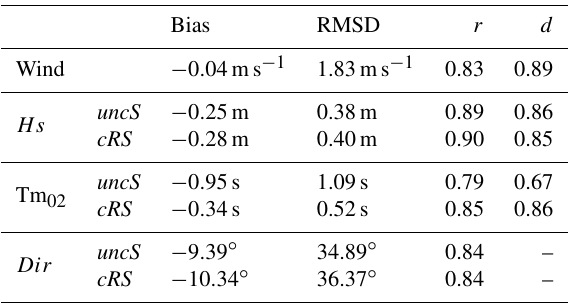
Table 1. Statistics comparing the 3m wind and the modeled wave parameters with the DB data.